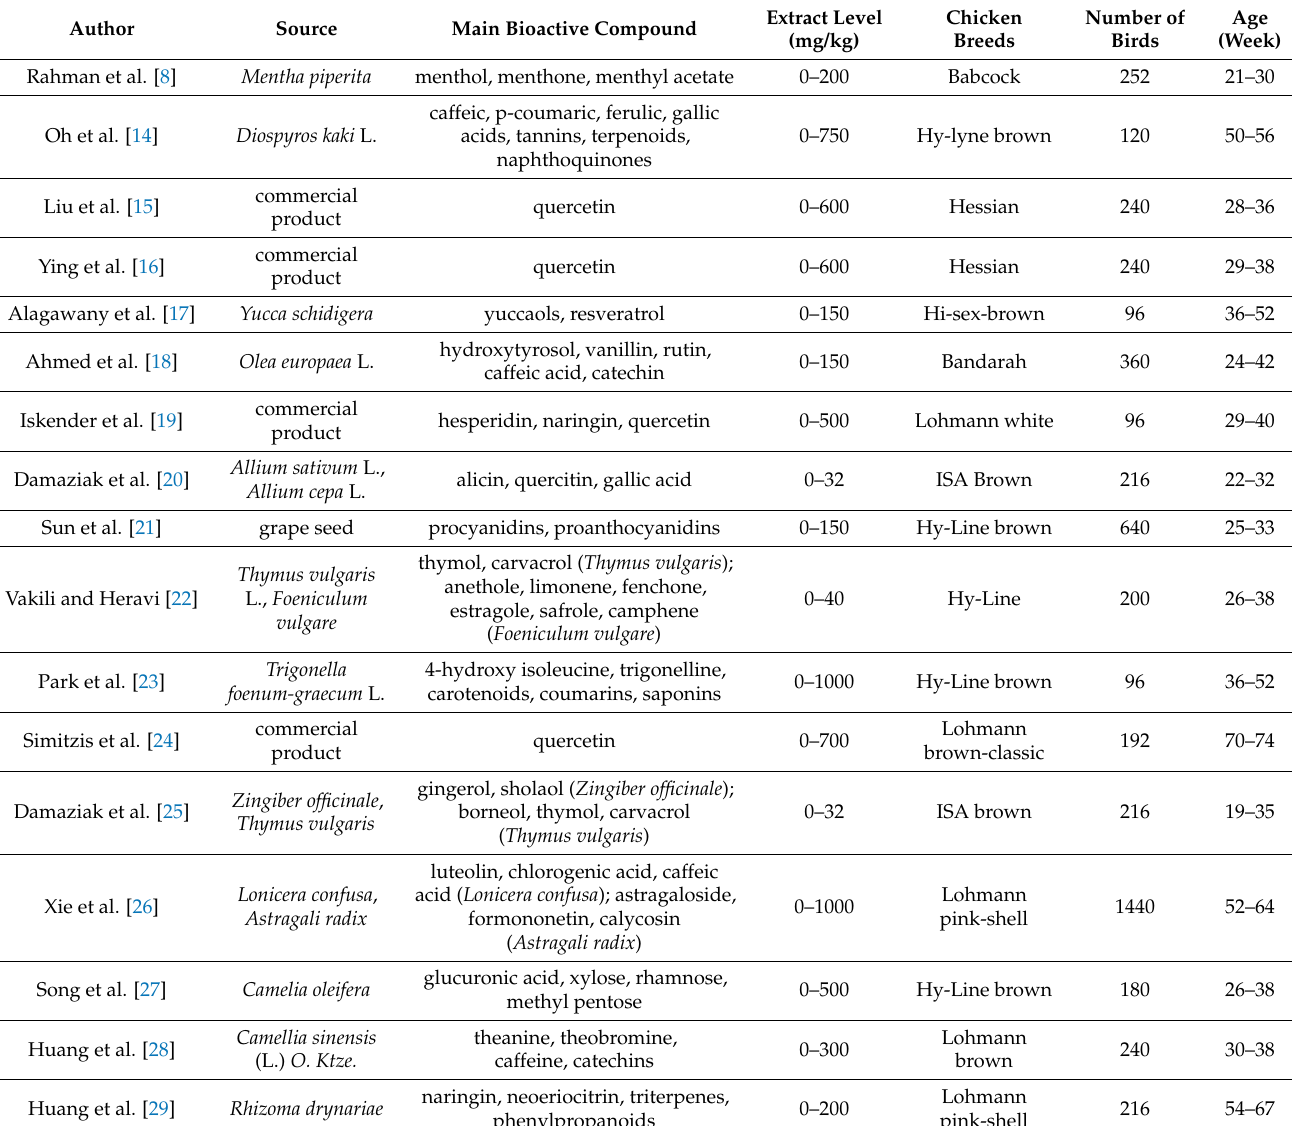
Table 1. Studies descriptions included in the